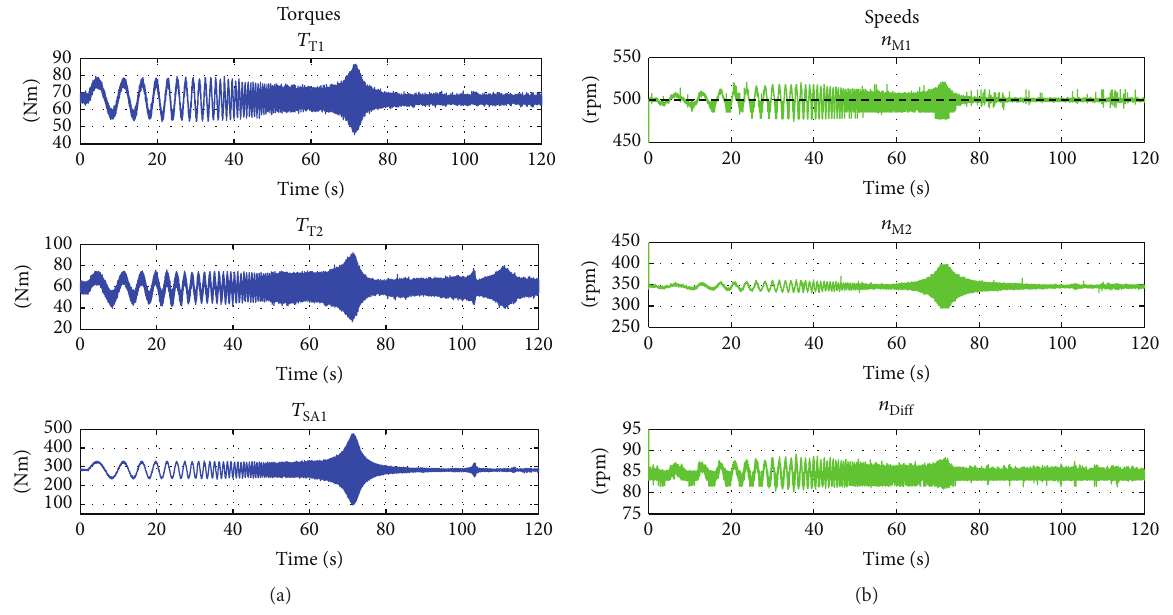
Figure 8: Time histories of the torques (a) and the speeds (b) during a chirp